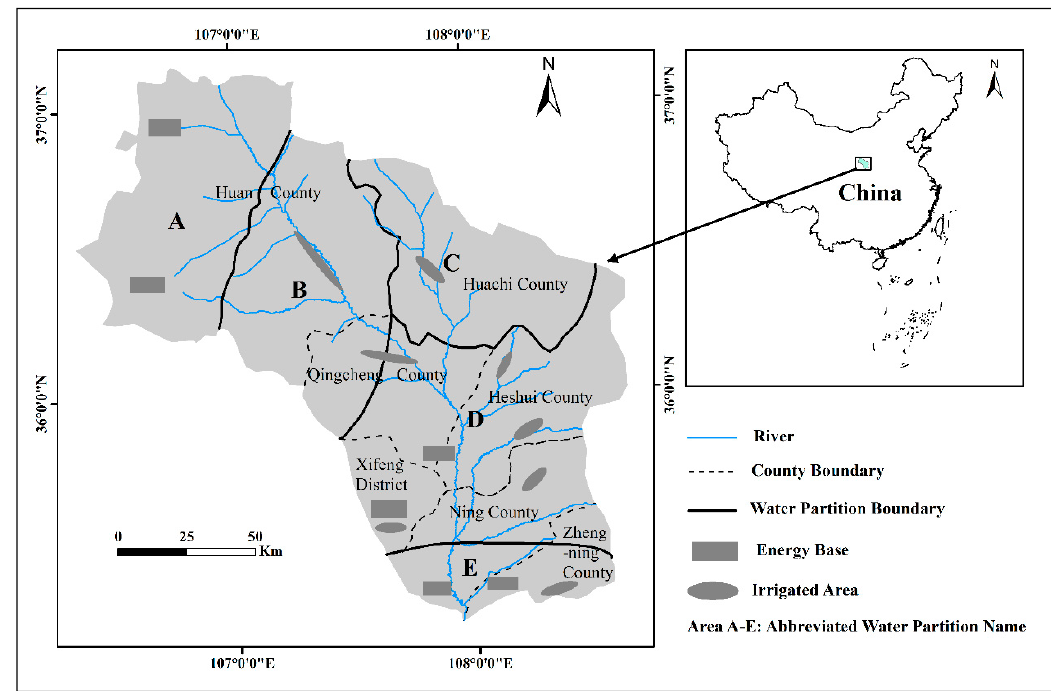
Figure 1. Water resource partitions and locations in Malian River Basin (Pastoral Energy Industry Partition, Farming-Pastoral Industrial Development Partition, Ecological Agriculture Preserved Partition, Sustainable Development for Petroleum and Coal Industry Partition, and Preserved Partition for Ecological Agriculture and Sustainable Coal Industry Development Partition were abbreviated as A , B , C , D , and E in the figure). A – E in the